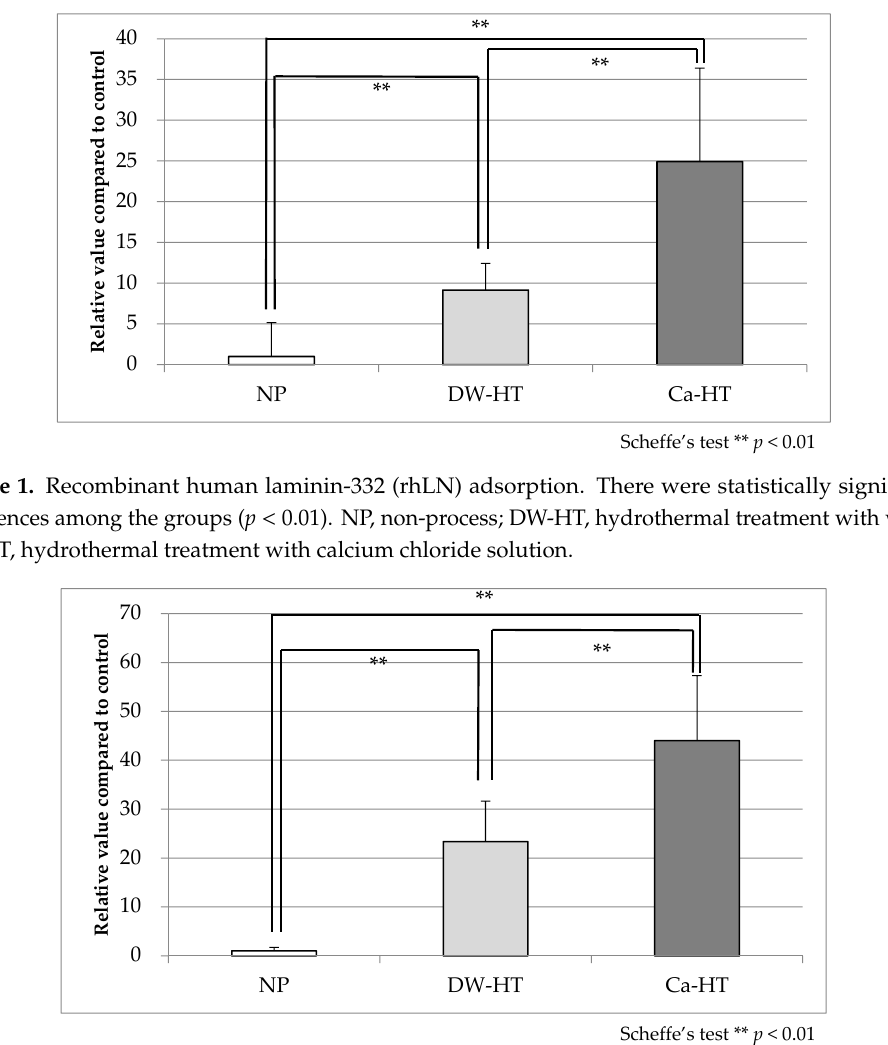
Figure 2. Recombinant human osteopontin (rhOPN) adsorption. There were statistically significant differences among the groups ( p < 0.01).